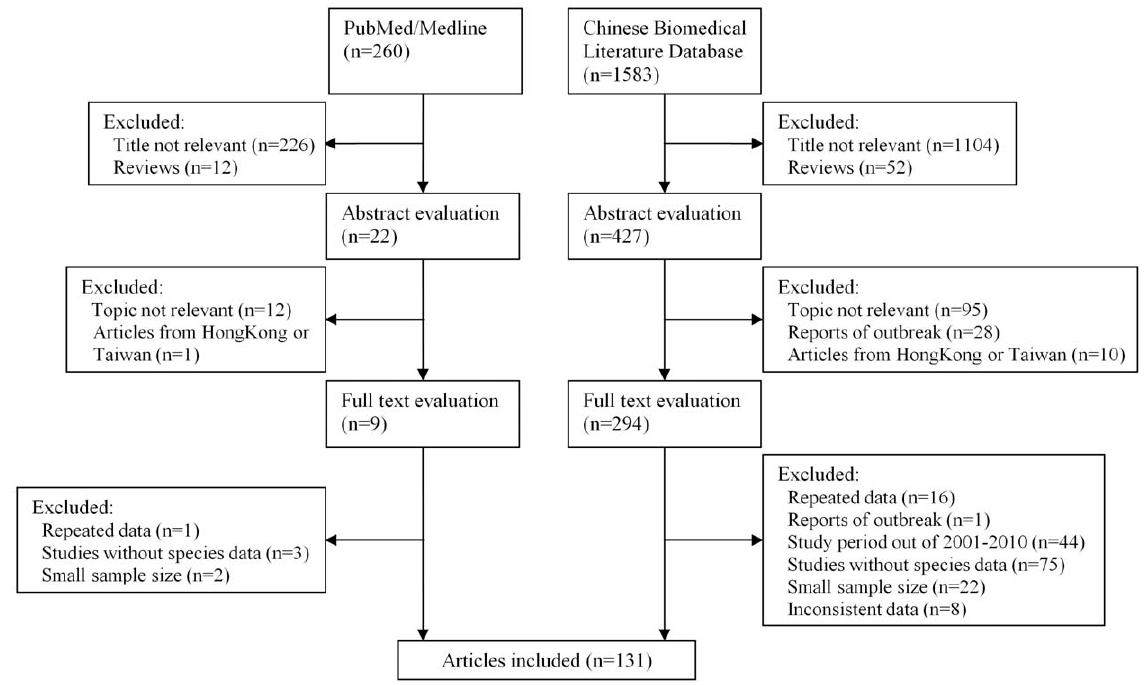
Figure 1. Flow diagram of study identification.